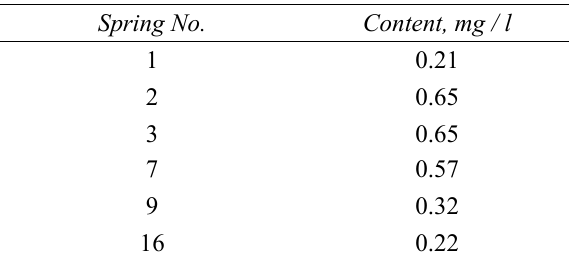
Table 3: Aluminium content in spring water near Obninsk Spring No.